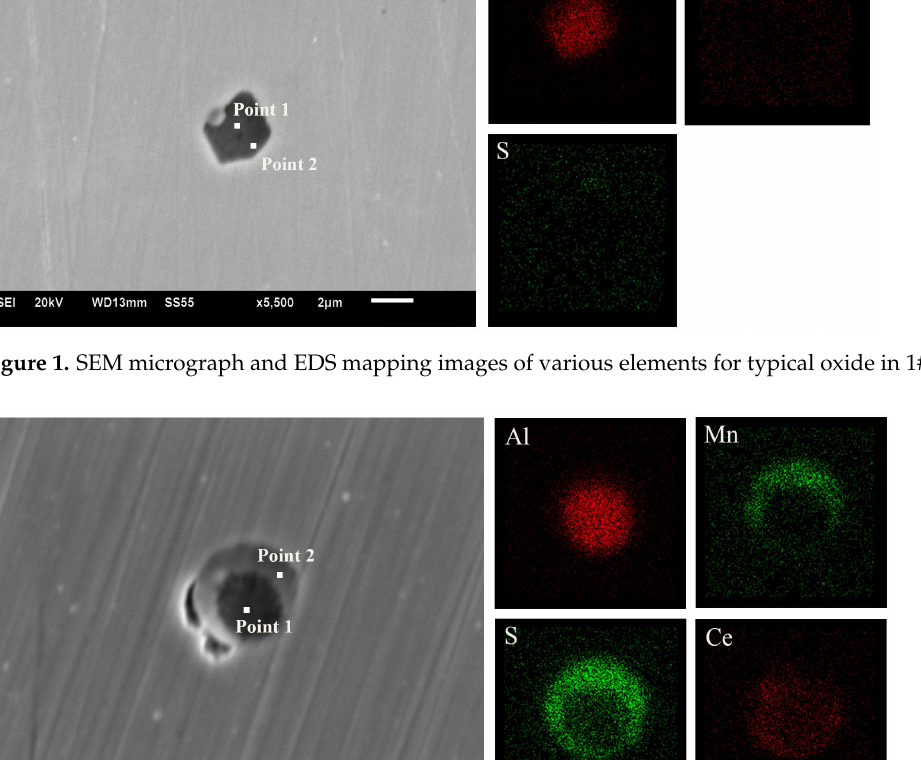
Figure 2. SEM micrograph and EDS mapping images of various elements for typical oxide in 2#. Table 2. EDS point analysis of typical oxides shown in the figures (mass percentage).